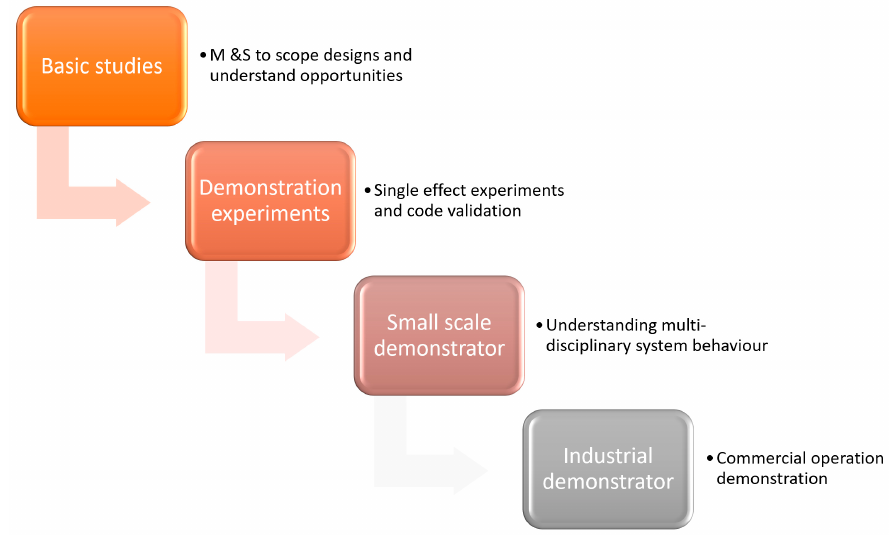
Figure 11. The four-step process proposed for the development of a breakthrough reactor system.